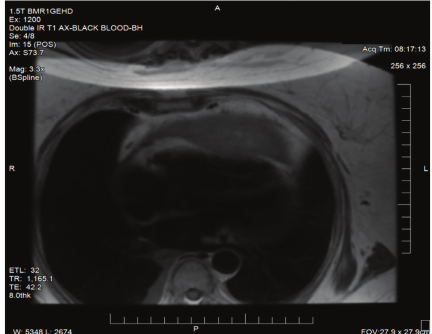
Figure 4: Cardiac MRI showing cystic solid mass arising in the per-